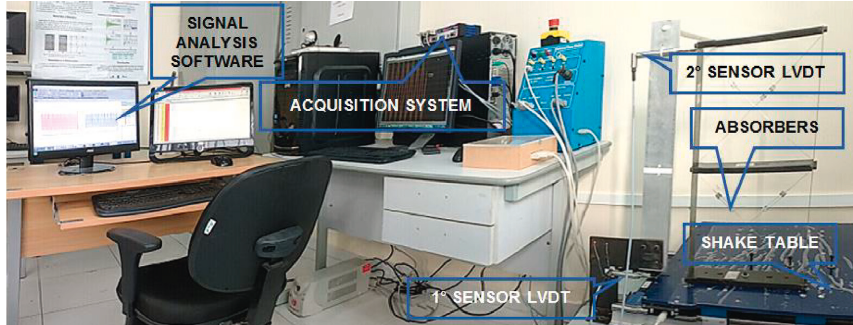
Figure 8: Experimental setup of the system under forced vibration.